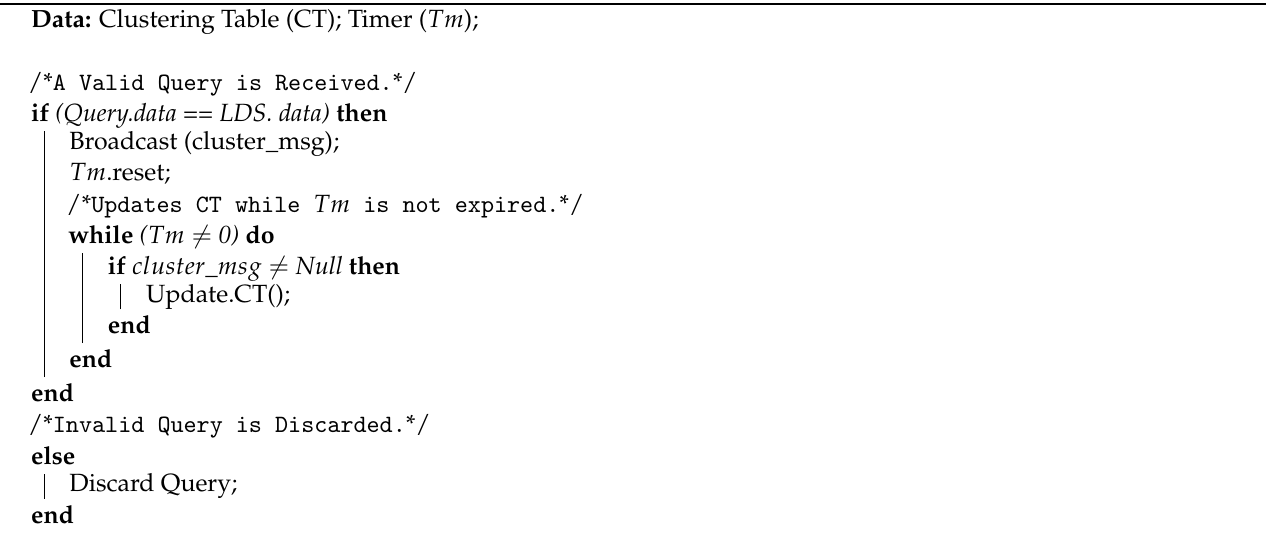
Algorithm 2: Clustering